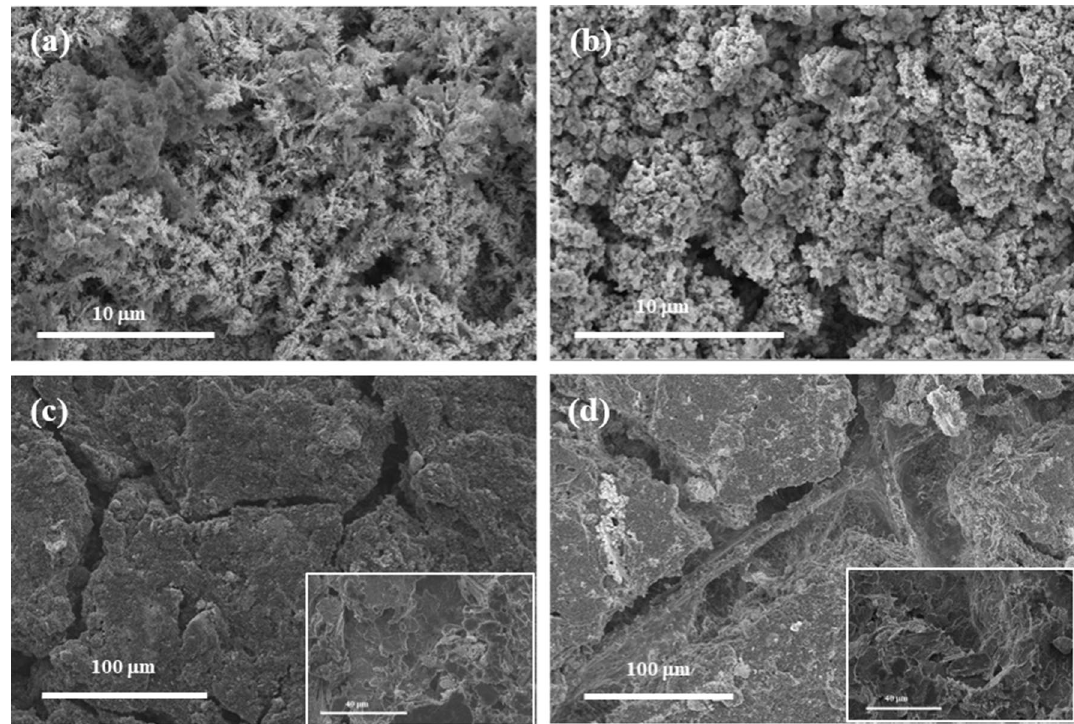
Figure 9. SEM images of Ni-Fe-Co(OH) 2 coated SS mesh electrode (OER) ( a ) before cycling and ( b ) after cycling. MnO x on carbon paper electrode (ORR) ( c ) before cycling and ( d ) after cycling; images of the back of the ORR electrode are displayed in the